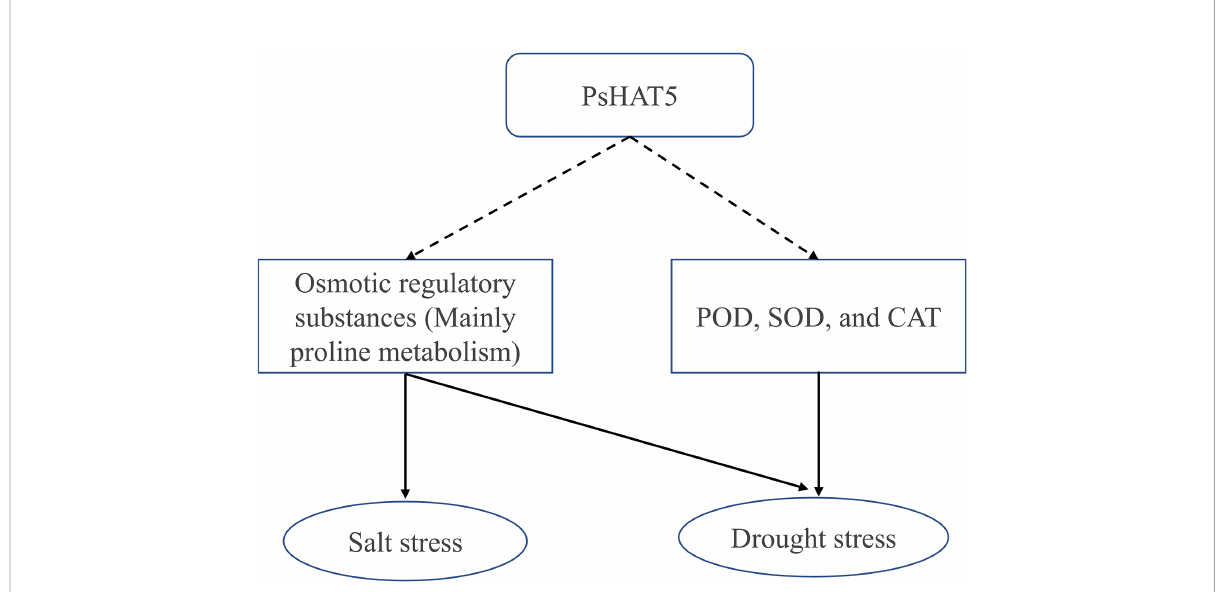
FIGURE 6 A pictorial representation of the role of PsHAT5 transcription factors in the regulation of drought and salt stress in tomatoes. Dotted lines indicate events that have not yet clearly occurred and are subject to further study, and the solid lines represent events that